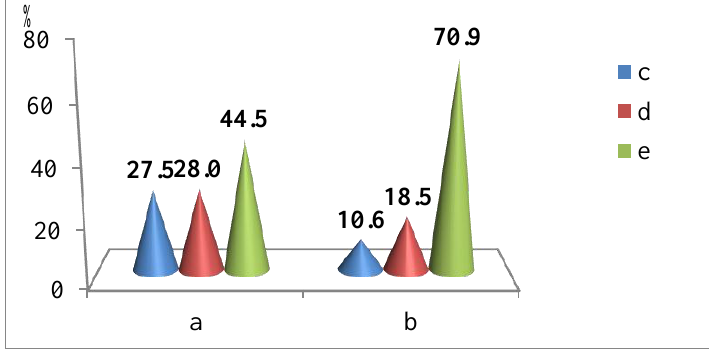
Fig.4. Quantity of time spent at computer, notebook or TV: a – weekdays; b – days off; c – less than 1 hour/day; d - 1-2 hours/day; e - 2 and more